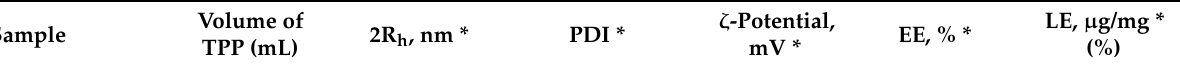
Table 8. Characteristics of loaded nanoparticles obtained by ionic gelation method (Scheme 1, system 4 and Scheme 1, system